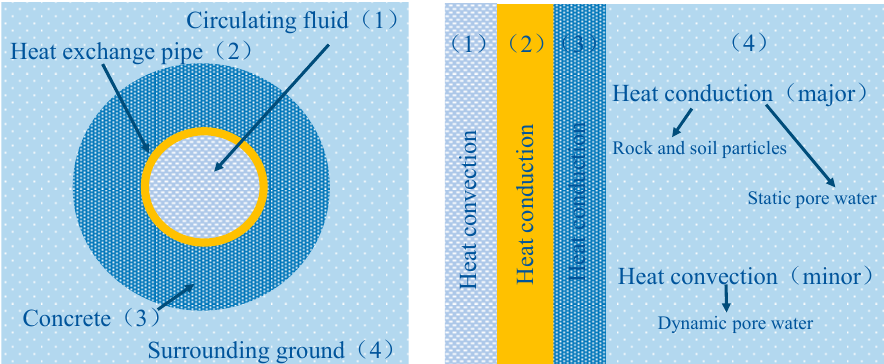
Figure 1. Schematic diagram of heat transfer process of energy pile.